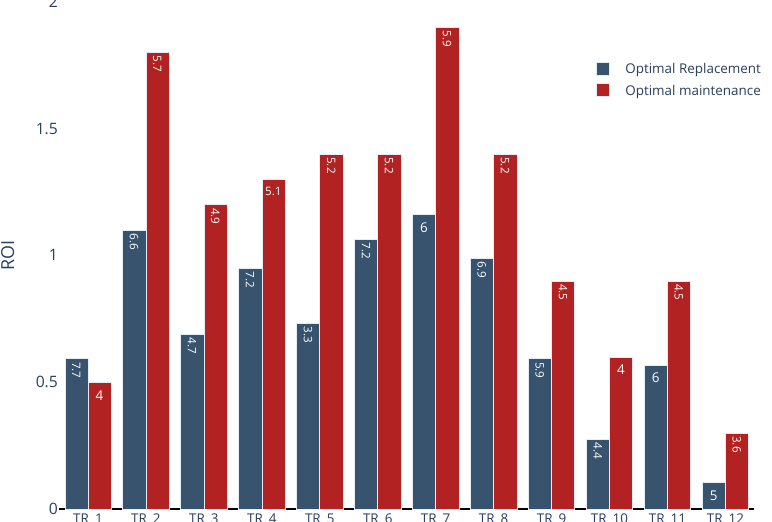
Figure 16. Comparison between ROIs obtained to employ an optimal replacement and a maintenance strategy for the entire asset fleet.